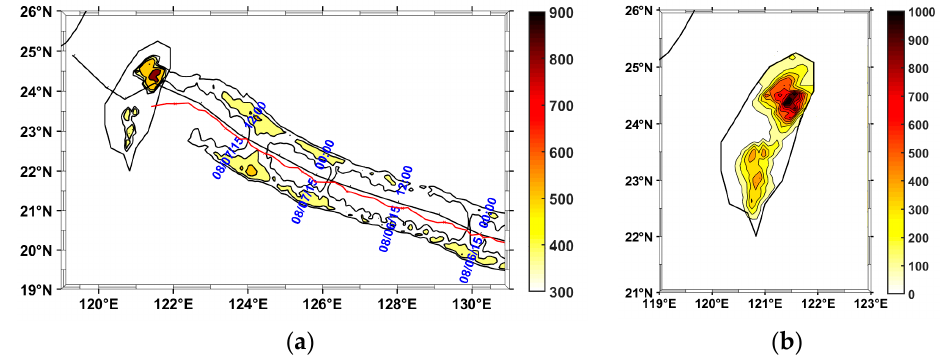
Figure 5. ( a ) Cumulative rainfall (mm) from 6 August 00:00 UTC to 8 August 00:00 UTC from WRF outputs. The solid black (red) line displays the best (WRF) track. ( b ) A close up, from Image a), of Taiwan.